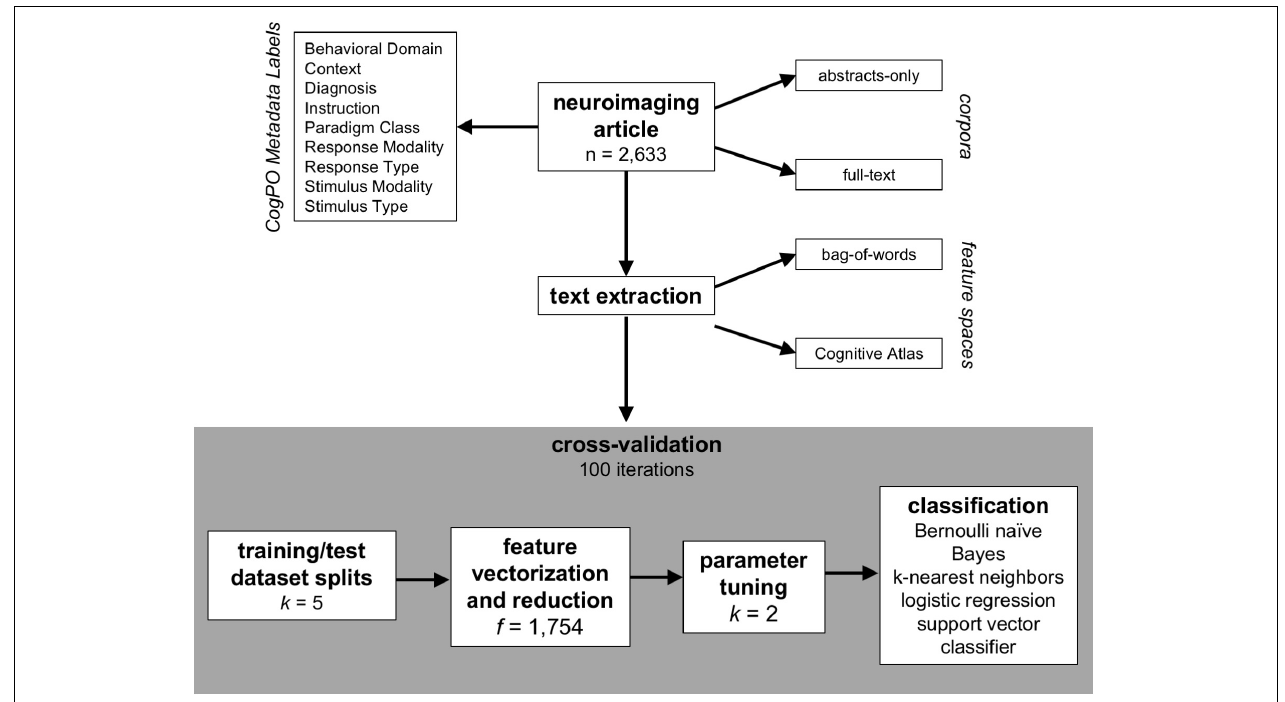
FIGURE 1 | Analysis plan. The schematic describes the approach utilized in this analysis to identify the best classifier for automating the annotation process for published neuroimaging articles. The articles have been manually annotated to with metadata labels described by the Cognitive Paradigm Ontology (CogPO) and can be evaluated based on the text in the abstracts-only or the full extent of the article. The text can be extracted using the raw terms in the article (bag-of-words) or based on usage of terms from a defined vocabulary (Cognitive Atlas). Then, a repeated (100 iterations) cross-validation technique is performed for generating the classifiers where first the full dataset is split into five equally sized subsets, which are then split into training (80%) and testing (20%) datasets. The features (bag-of-words or Cognitive Atlas terms) are vectorized based on frequency of appearance and reduced to the only the most frequently used terms. Then, based on the specific classifier being used, the appropriate hyperparameters are tuned based on the training dataset, and then a classifier is constructed for each CogPO metadata label using the training